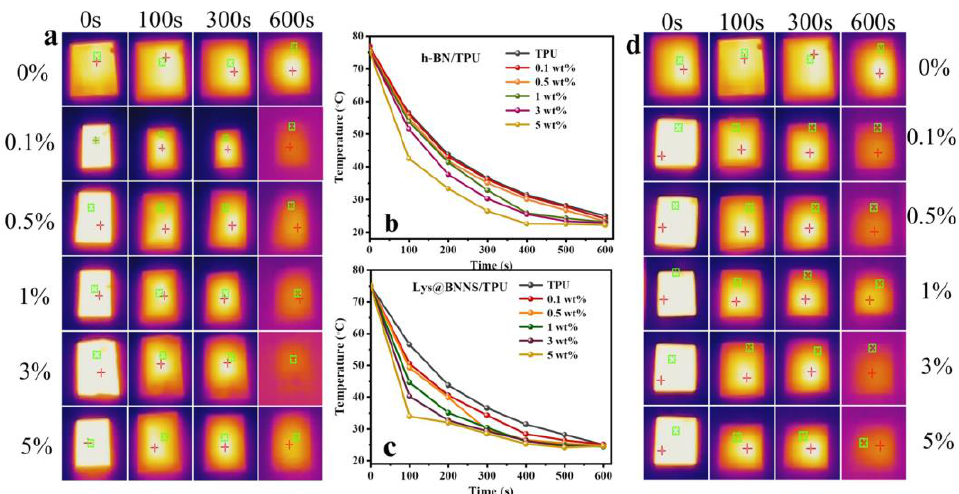
Figure 7. ( a ) Infrared thermal images and ( b ) surface temperature variation with cooling time for TPU and h-BN/TPU; ( c ) infrared thermal images and ( d ) surface temperature variation with cooling time for TPU and Lys@BNNS/TPU.